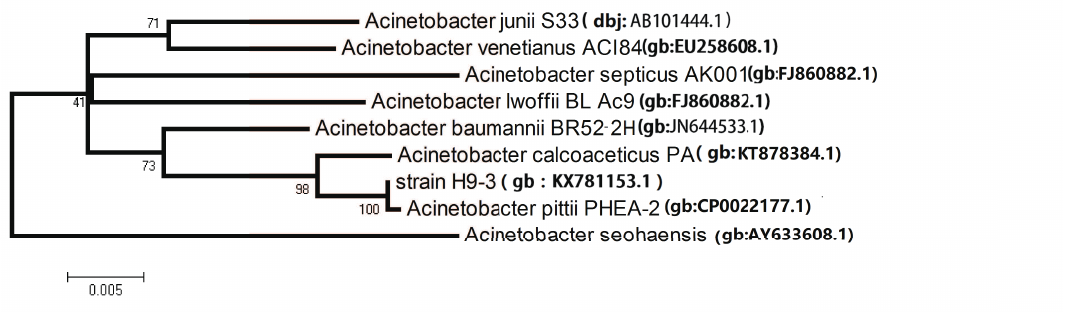
Figure 2. Phylogenetic tree presenting the position of strain H9-3.